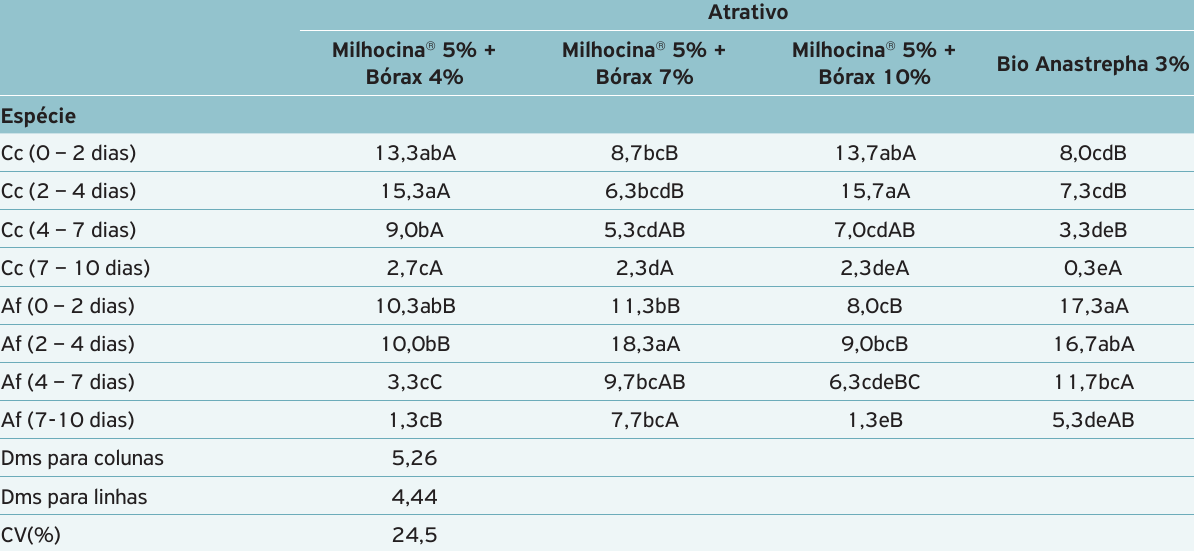
Tabela 2. Valores médios de fêmeas de Ceratitis capitata e de Anastrepha fraterculus capturados por armadilhas McPhail contendo diferentes atrativos alimentares, mantidas em gaiolões de campo durante quatro idades dos atrativos. Campinas, São Paulo, janeiro a fevereiro, 2006.